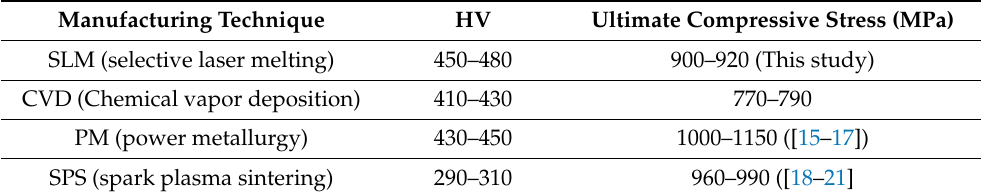
Table 3. The relationship between mechanical properties and manufacturing techniques.